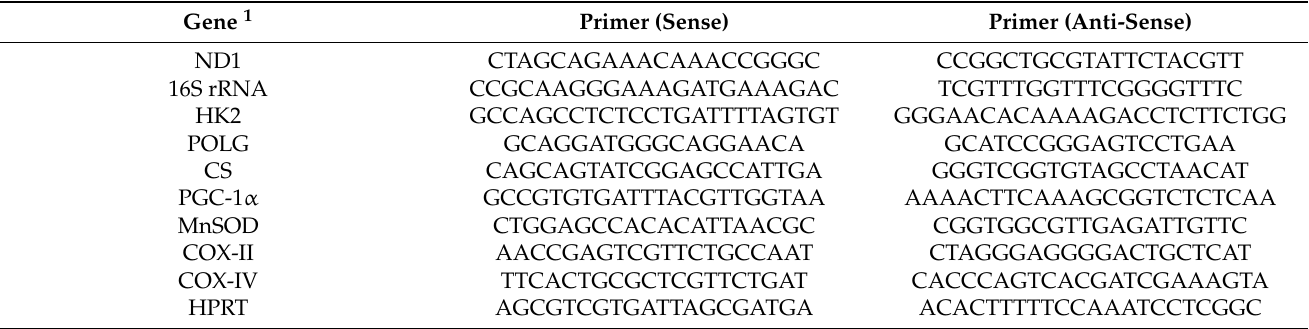
Table 1. Sequence of primers used for qPCR